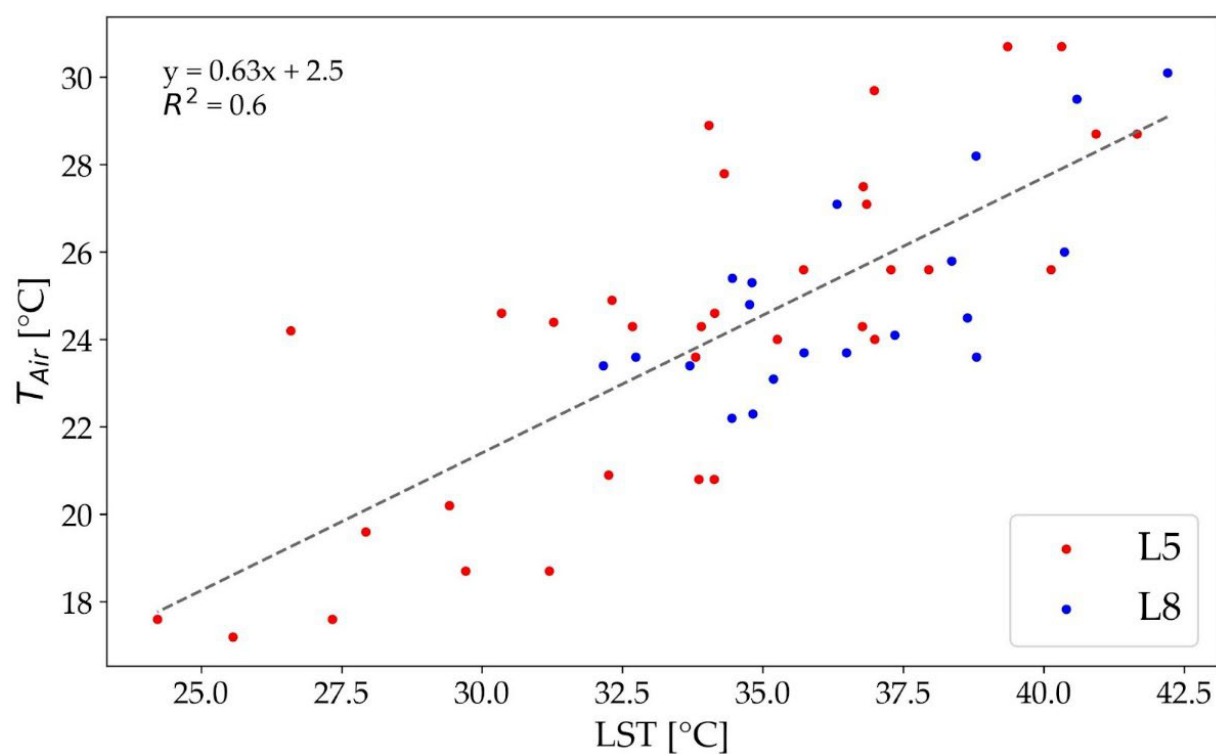
Figure A1. Stuttgart and its surrounding area. Green hatching indicates the valid surrounding area in the 20 km buffer around Stuttgart used to calculate the average rural land surface temperature (LST). Urban areas, areas covered with clouds, and areas with elevation deviating more than ±100 m from the mean elevation of Stuttgart were excluded.